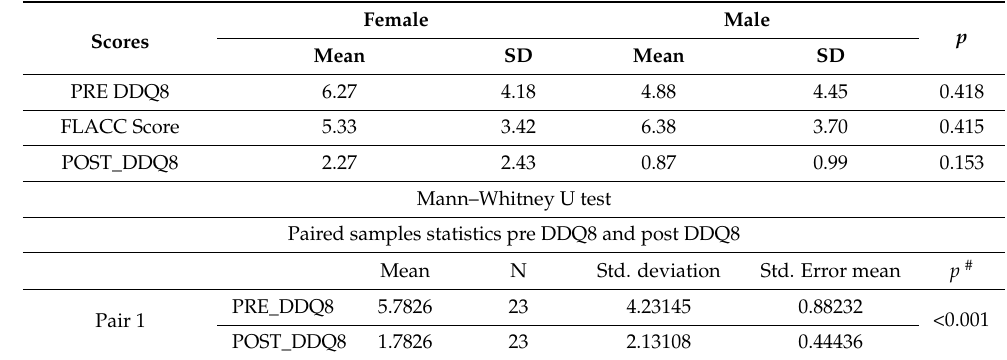
Table 6. Comparison of pre DDQ, FLACC and post DDQ scores between gender.